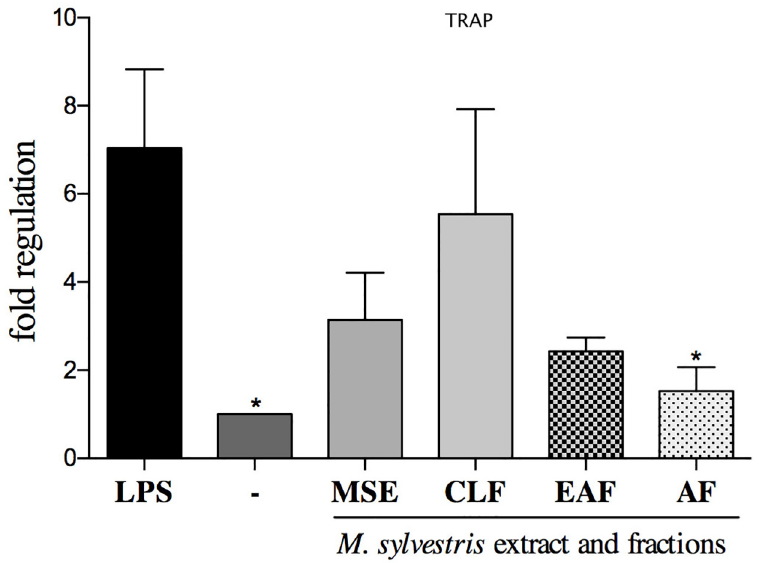
Fig 6. MSE and fractions effect on TRAP (tartrate-resistant acid phosphatase) expression levels. Quantification of the relative transcript amounts performed by qpcR with 10 ng of each cDNA. Data quantification was performed using 2(-DeltaDeltaC(T)). Statistical analyses were performed by one-way ANOVA followed by Dunnett ’ s post-hoc tests. * p < 0.05 significantly different from LPS-stimulated